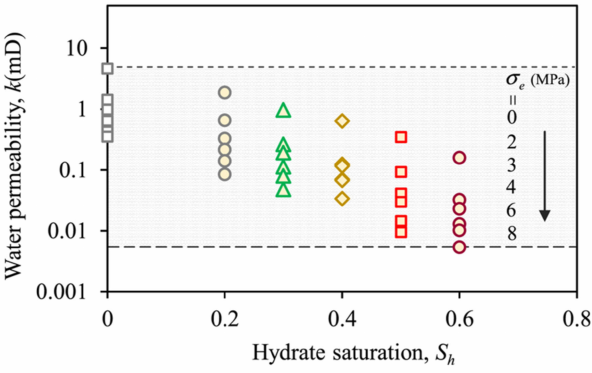
Figure 38. Measured water permeability with hydrate saturation of 0–0.6 at effective stress between 0 and 8 MPa reprinted from [20] with permission from